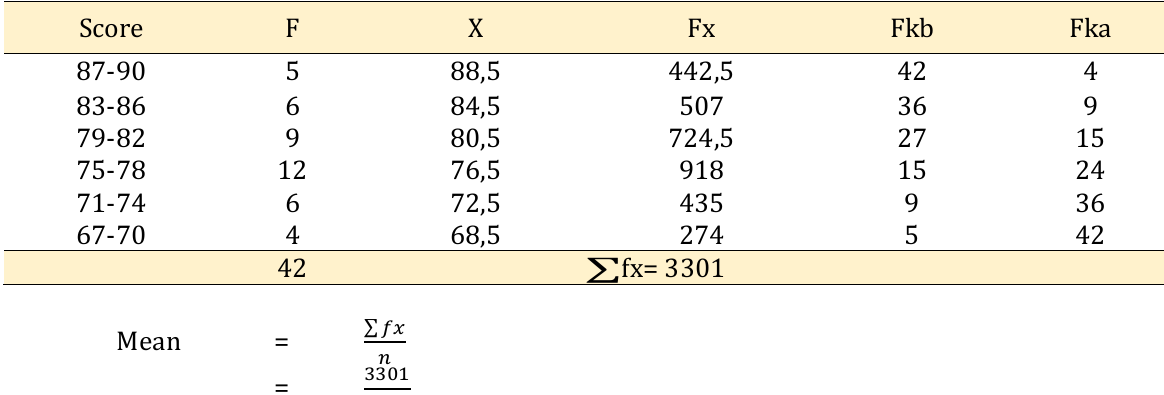
Table 5: Statistical Data of the students' Speaking